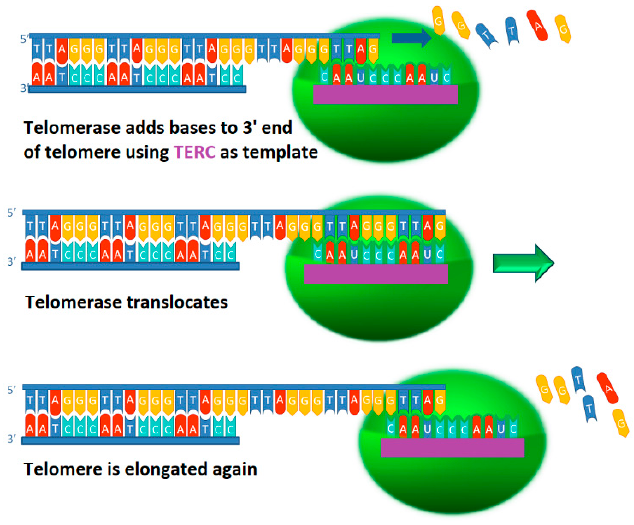
Figure 1. Telomere elongation by telomerase. After binding to the 3 (cid:48) end of telomere, telomerase starts a cycle of elongation, translocation, elongation until the final dissociation (Image modified from Fatma Uzbas. “Working principal of telomerase” Licensed under: CC BY-SA